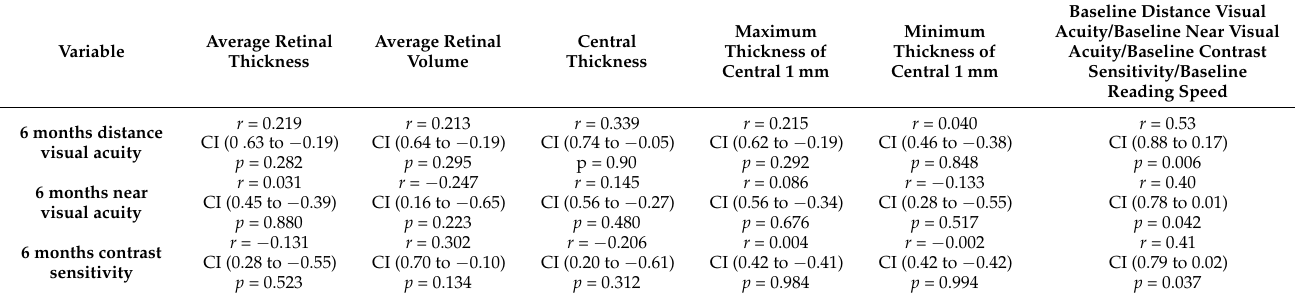
Table 2. Correlation between quantitative OCT paramaters and visual functions six months after